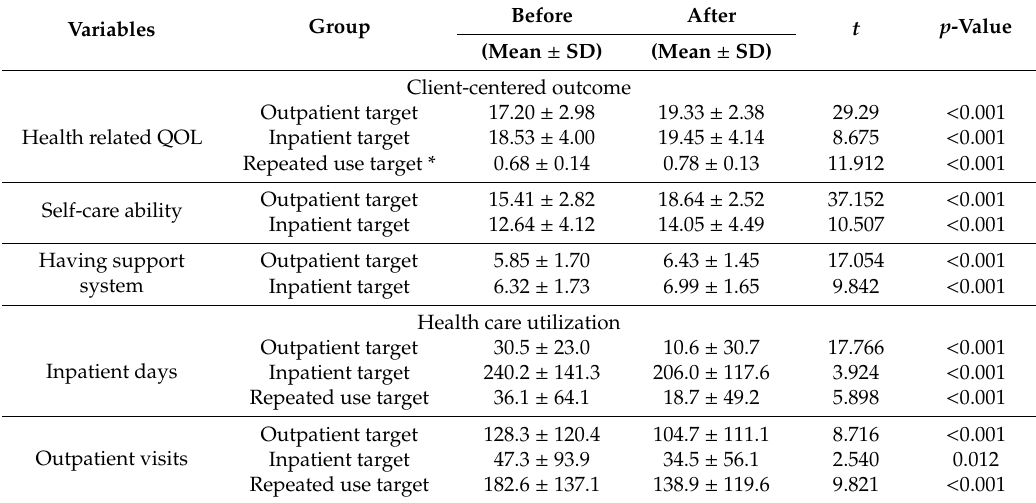
Table 3. Service outcome of community-based case management by the target